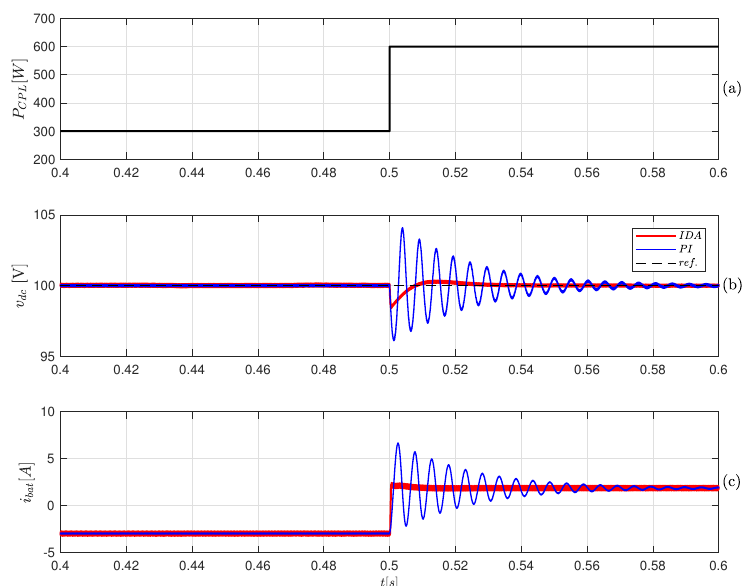
Figure 5. Performance of the MG for changes in the CPL (IDA-PBC in red, PI in blue): ( a ) load power ( P CPL ); ( b ) DC-link voltage ( v dc ); ( c ) BES current ( i Bat